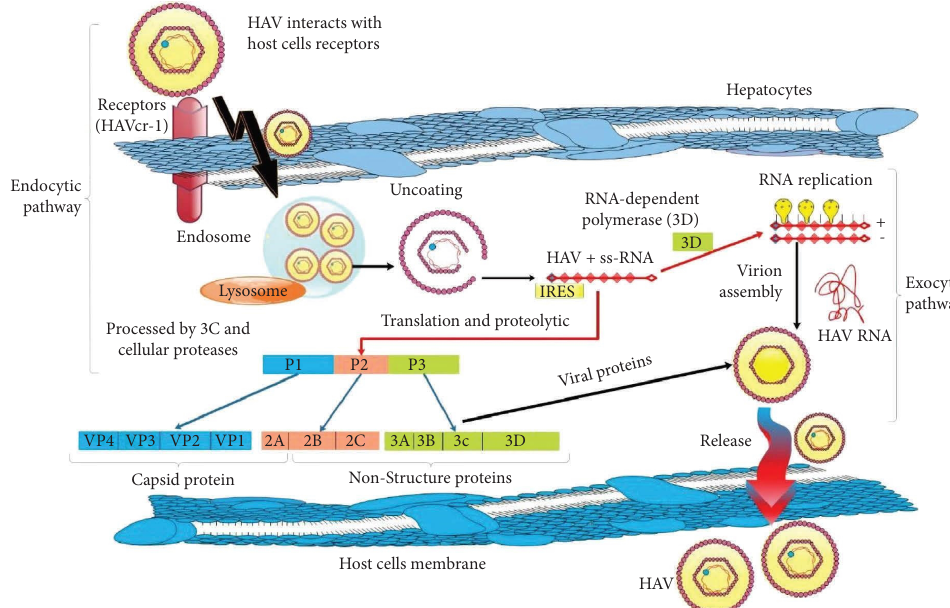
Figure 2: HAV replication cycle. At the hepatocyte’s basolateral membrane, the HAV virus interacts with host cell receptors, and its uncoated RNA is released into the cytoplasm. Te cap-independent, IRES-driven translation of the positive-strand RNA genome produces polyproteins. Nonstructural proteins involved in genome replication (2B, 2C, 3AB, 3Dpol), the protease (3Cpro), and capsid proteins are produced by proteolytic processing of polyprotein. 2BC causes alterations in intracellular membranes, leading to the formation of a membrane-bound replicase complex that guides the production of a matching minus-strand RNA, which is subsequently employed as a template to make numerous new replicas of the RNA genome. Newly generated positive-strand RNAs are instructed to do more translation or RNA biosynthesis, or they can be packed into capsids to produce intracellular viral ofspring. Tese freshly formed viral components are attracted to multivesicular bodies for eventual egress from infected cells into the biliary canaliculus or hepatic sinusoids via the apical plasma membrane and basolateral plasma membranes, respectively. Te RNA genome is exposed after entering the cell, and the host ribosomes attach it to create polysomes. A viral RNA polymerase translation synthesizes viral particles that can be assembled and released into the biliary